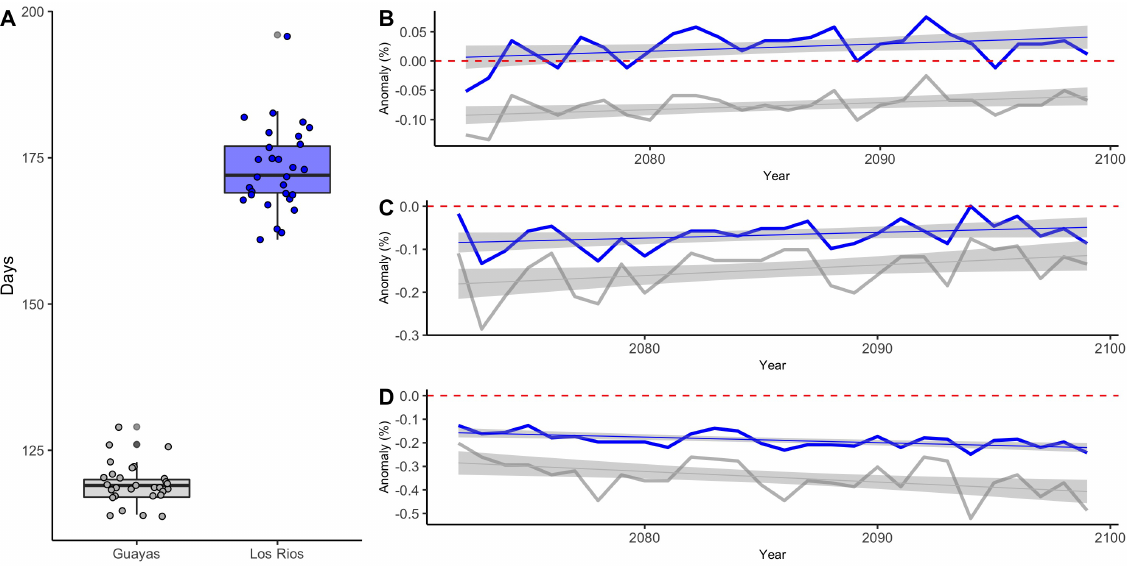
Figure 7. Percent change anomalies in rice harvest day projected from RegCM4 RP VSM output ( A ) for Guayas (gray), and Los Ríos (blue) Provinces with corresponding changes over the time period under RCP 2.6 ( B ), RCP 4.5 ( C ), and RCP 8.5 ( D ). The lines represent the annual changes in yield. Grey shaded areas in ( B – D ) represent 95% prediction